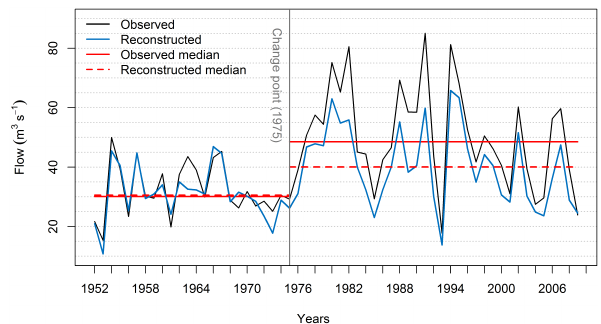
Figure 10. Observed and median of 328 reconstructed series for March mean flow. Solid red line is the observed median flow before (1952–1975) and after (1976–2009) the detected change point; dash red is the reconstructed median flow for the same